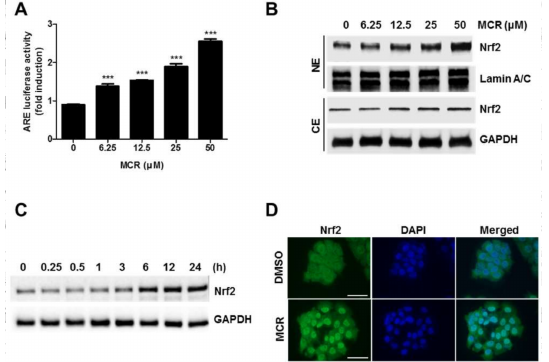
Figure 2. MCR stimulates Nrf2 activation. ( A ) HaCaT-ARE cells were treated with different concentrations of MCR for 24 h and ARE-luciferase activity was measured using a luminometer; ( B ) Cells were treated with different concentrations of MCR for 24 h, and nuclear and cytosolic Nrf2 levels were measured using western blot analysis; ( C ) Cells were treated with 50 µ M of MCR for indicated time periods, and whole cell lysates were subjected to western blotting; ( D ) HaCaT cells were treated with 50 µ M of MCR for 12 h, and the nuclear localization of Nrf2 (green) was detected using immunocytochemical analysis, as described in the Materials and methods section. Lamin A/C and GAPDH were used as nuclear and cytosolic loading controls, respectively. NE, nuclear extract; CE, cytosolic extract. ***, p < 0.0001; Bar, 50 µ